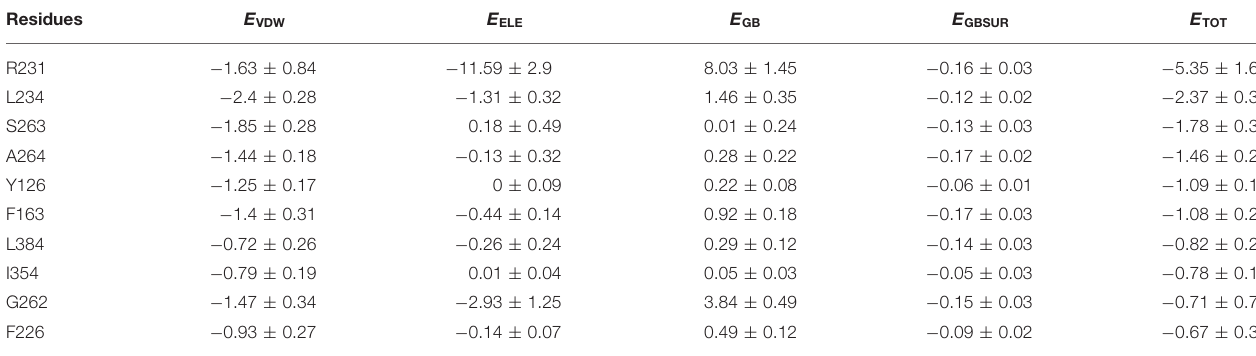
TABLE 1 | The top 10 key residues of IDO1 contributing to the association with INCB024360. Residues E VDW E ELE E GB E GBSUR E TOT R231